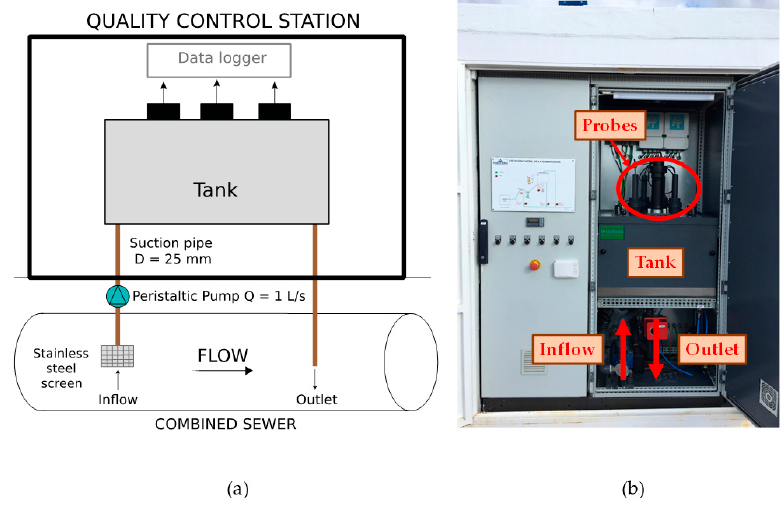
Figure 2. ( a ) Scheme of Quality Control Station devices; and ( b ) Image of QCS.